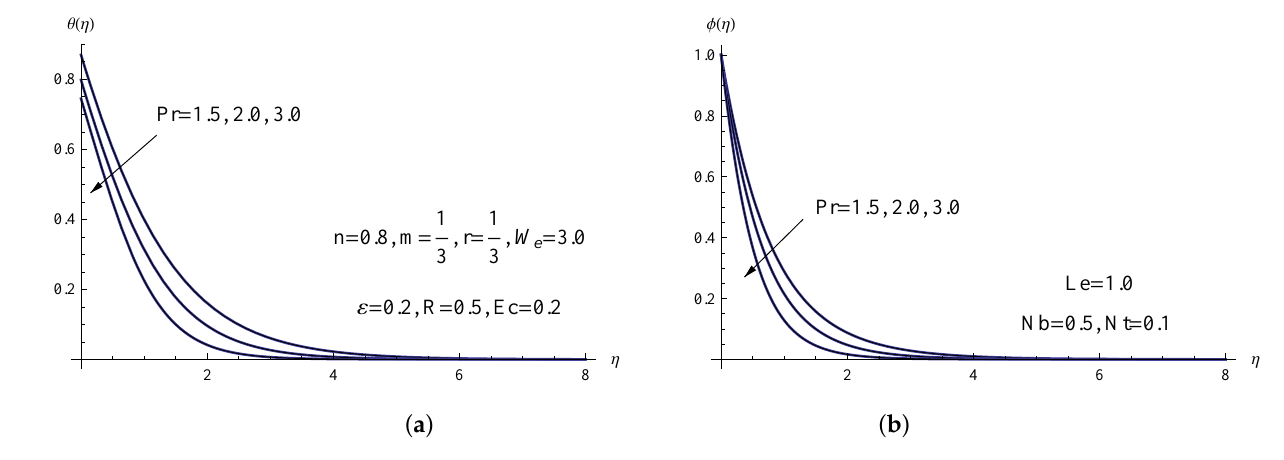
Figure 9. ( a ) θ ( η ) via Pr ; ( b ) φ ( η ) via Pr .